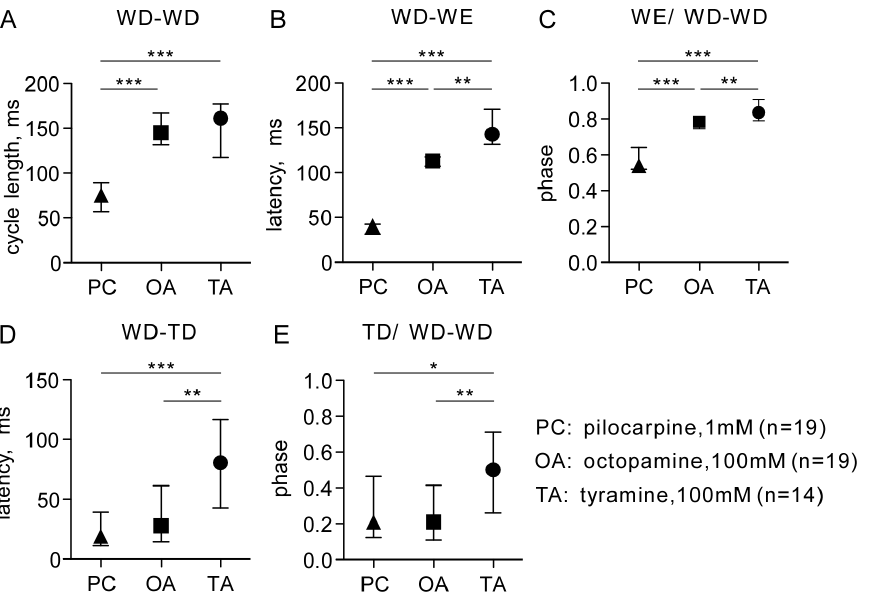
Figure 6. Charts comparing key features of fictive flight patterns released by pilocarpine (PC, triangles: 1 mM), octopamine (OA, squares: 100 mM) and tyramine (TA, circles: 100 mM). A Flight rhythm cycle length (WD-WD), B WD-WE latency, C phase of wing elevator in wing depressor cycle (WE/WD-WD), D WD-TD latency (coupling of leg unit TD to the wing unit WD), E phase of leg unit in wing depressor cycle (TD/ WD-WD). Symbols give the median, ticks the interquartile range and asterisks significant differences between indicated groups (Mann Whitney U test for unpaired data sets *p , 0.05, **p , 0.01, ***p , 0.001); n in the key gives numbers of preparations for each group evaluated.